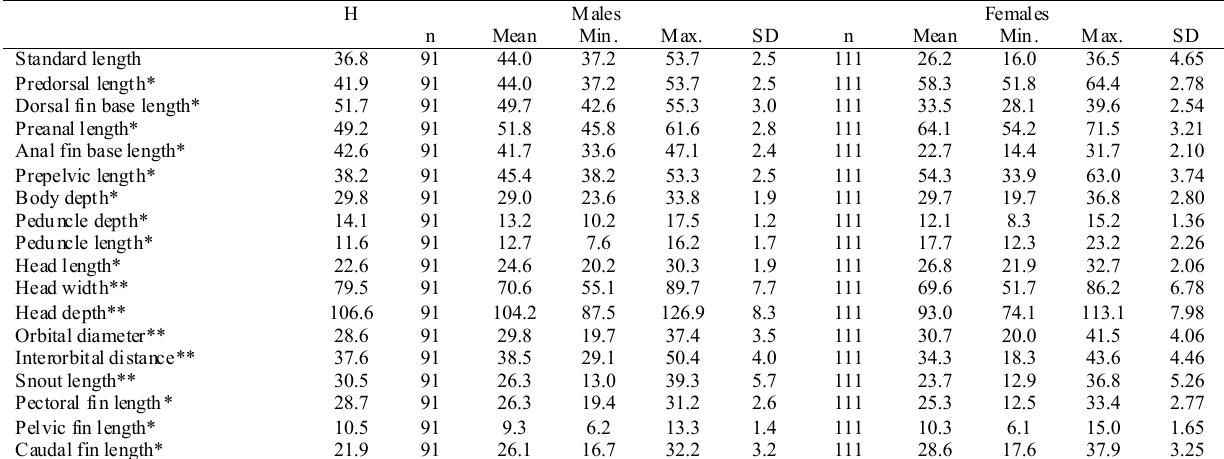
Table 1. Morphometric data of Austrolebias quirogai ; *expressed as percentage of standard length, ** expressed as percentage of head length; H = holotype; SD = standard deviation.